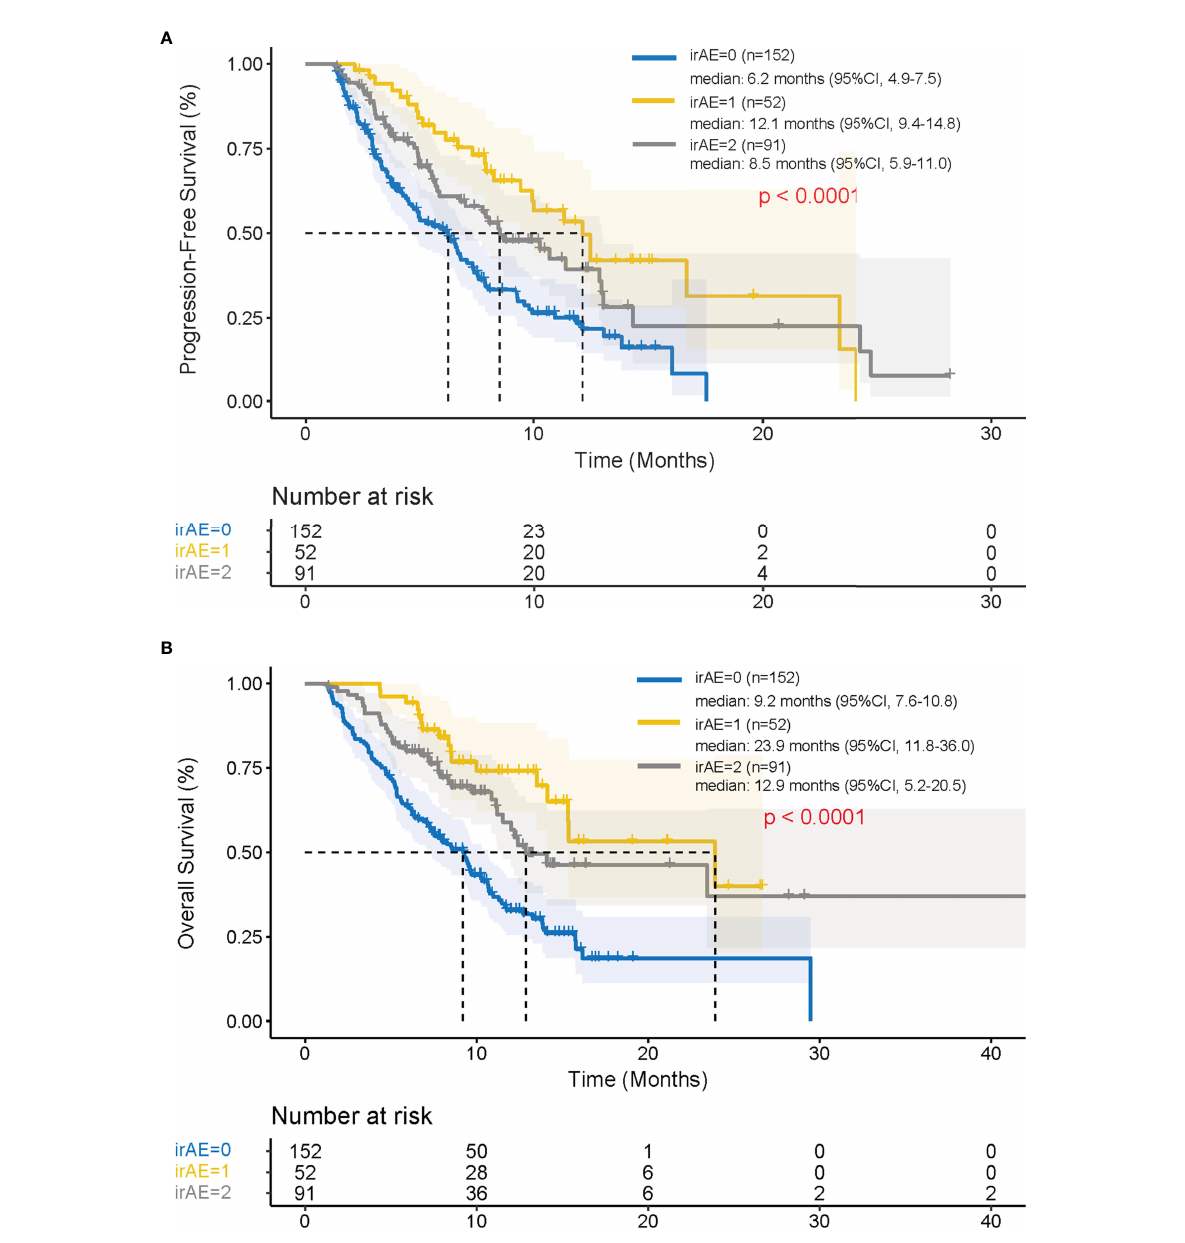
FIGURE 3 Progression-free survival and overall survival after the initiation of PD-1 inhibitors depending on the number of irAEs using Kaplan-Meier method. Kaplan – Meier curves for (A) progression-free survival and (B) overall survival in patients with ≥ 2 irAEs compared with those with one irAE and none irAEs. irAEs, immune-related adverse events; CI, con fi dence